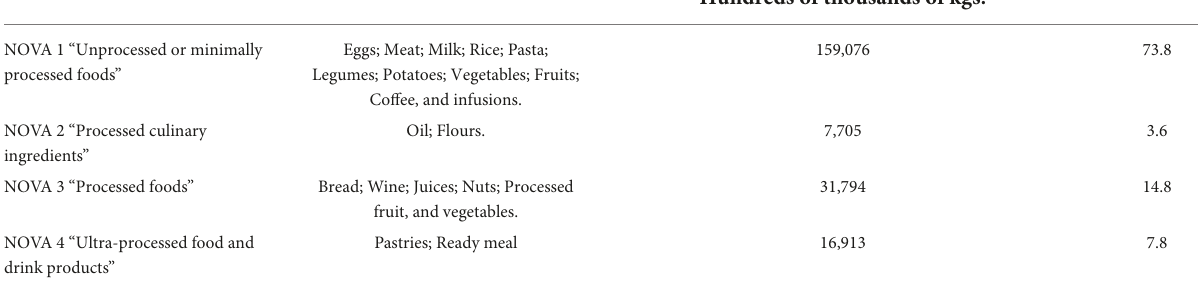
TABLE 5 Ninteen food categories-with organic and non-organic consumption data available for Spain in 2020-classified according to NOVA. NOVA group Food categories Total consumption (organic and non-organic). Hundreds of thousands of